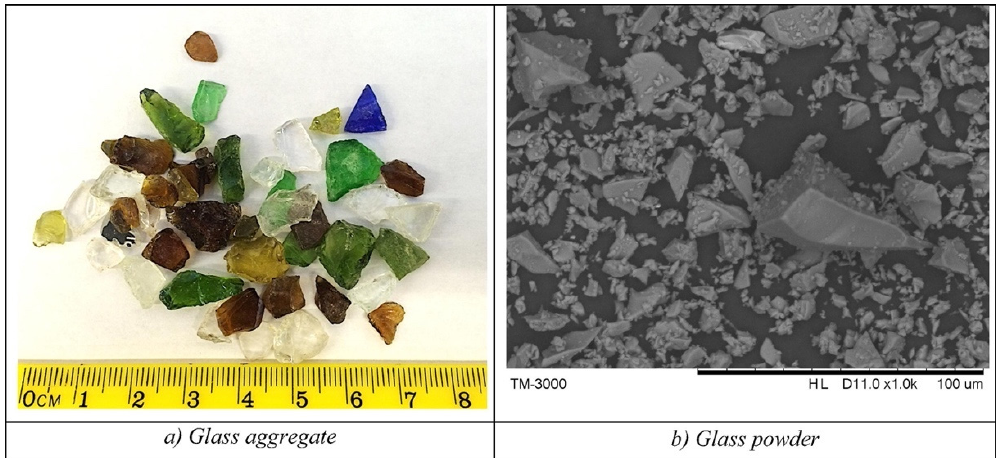
Figure 7. Example of crushed glass using for improving concrete properties. Reprinted with permission from [52]. Copyright©2016, Elsevier B.V.